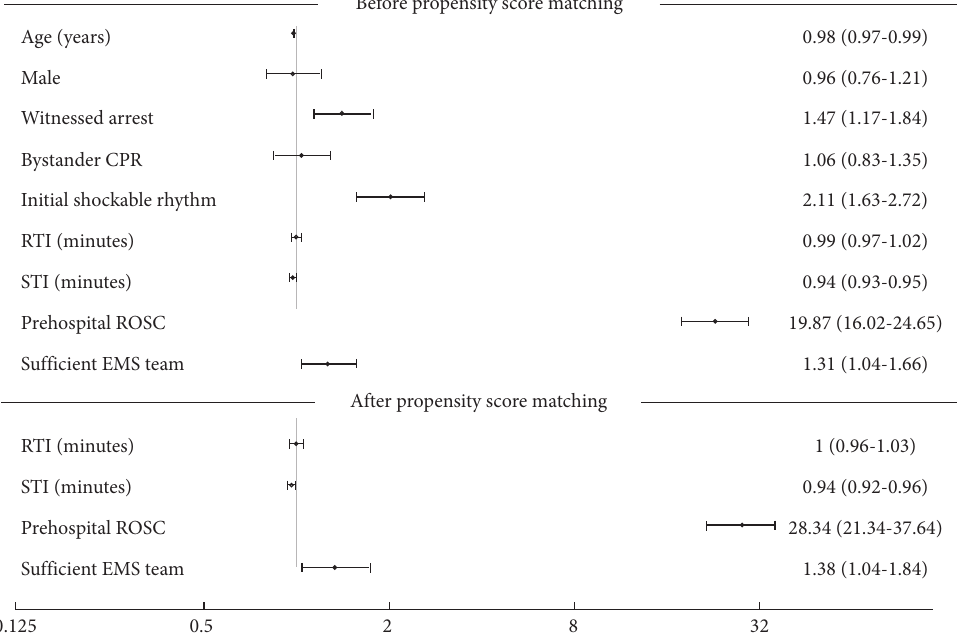
Figure 2: Forest plot of multivariable logistic regression analysis for predicting survival admission. Adjusted odds ratios for survival outcomes before and after propensity score matching with 95% confidence interval (CI). CPR, cardiopulmonary resuscitation; RTI, response time interval; STI, scene time interval; ROSC, return of spontaneous circulation.